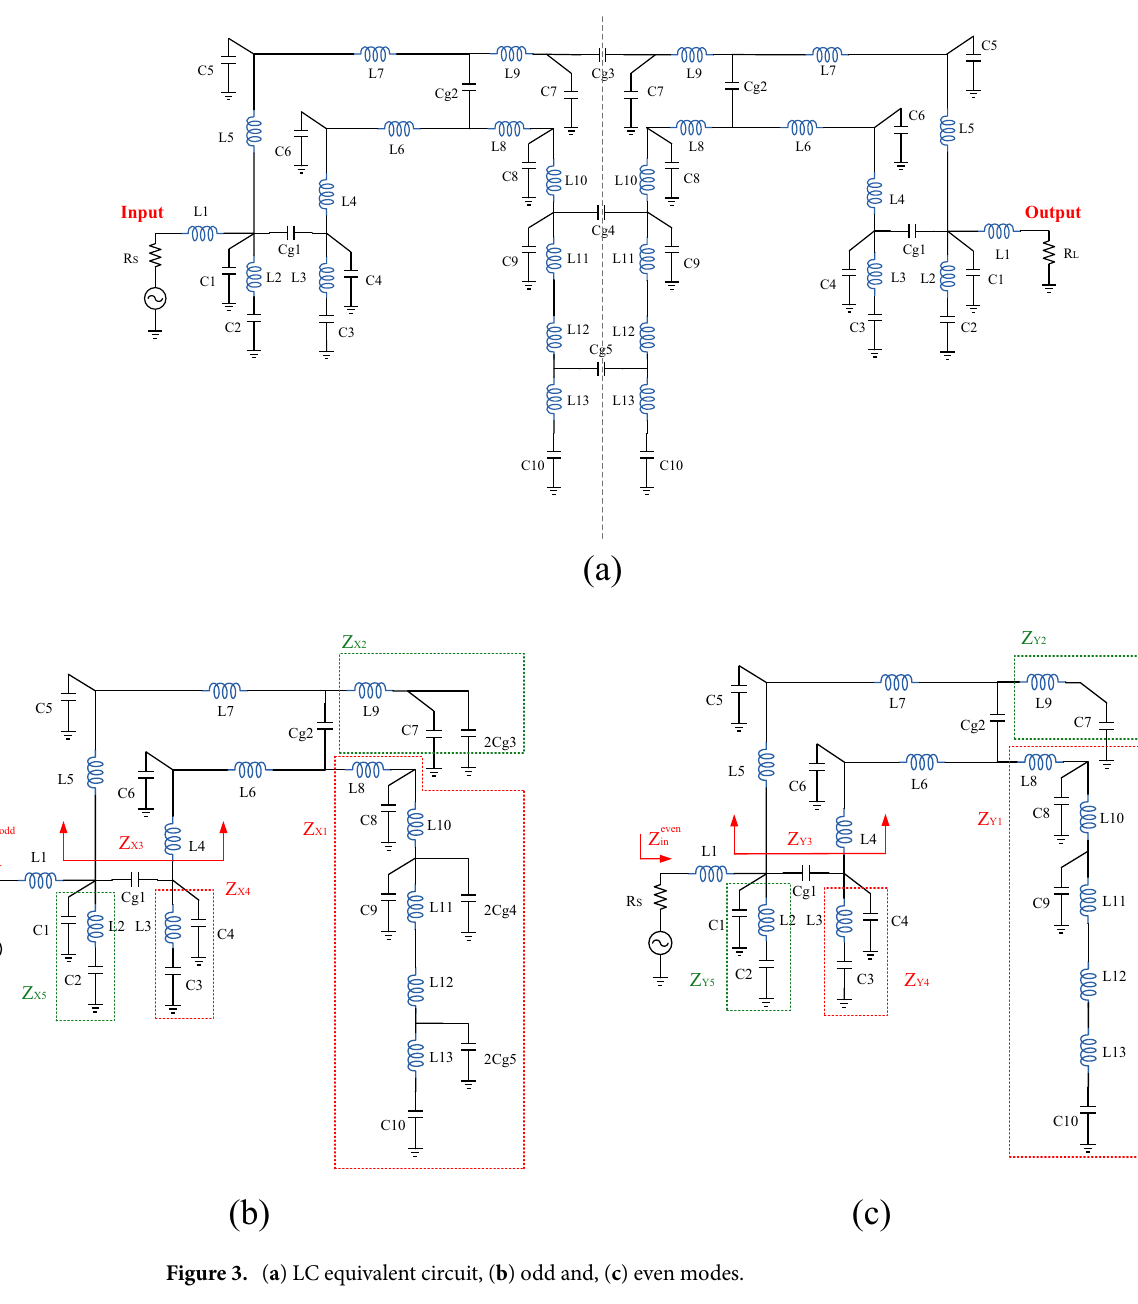
Figure 3. ( a ) LC equivalent circuit, ( b ) odd and, ( c ) even